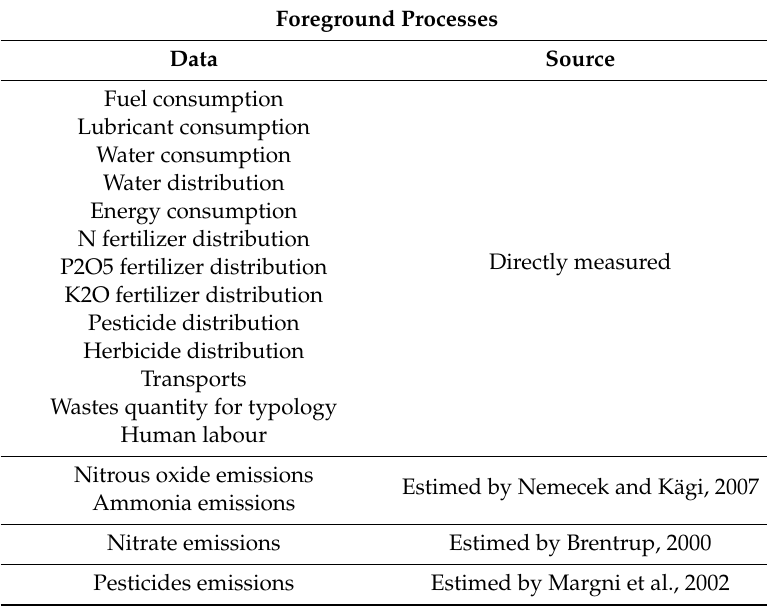
Table 1. Data quality and data